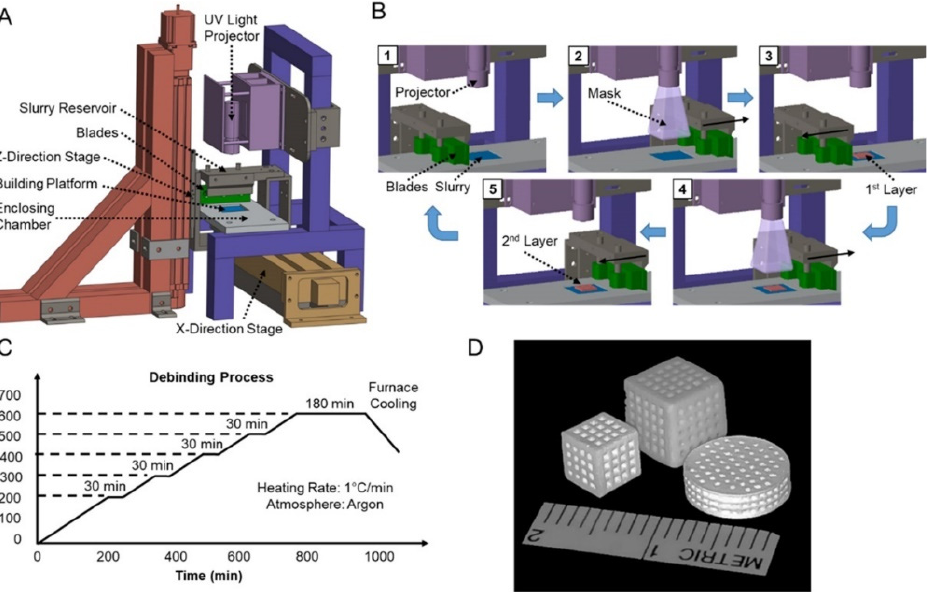
Figure 9. Diagram of β -TCP scaffold fabrication using SEPS. ( A ) 3D printer setup. ( B ) Layer-by-layer fabrication process. ( C ) Postprocess procedural de-binding protocol to remove excess binder resin solution from the β -TCP-printed component. ( D ) Photographs of 3D-printed β -TCP scaffolds in various shapes and sizes [135].